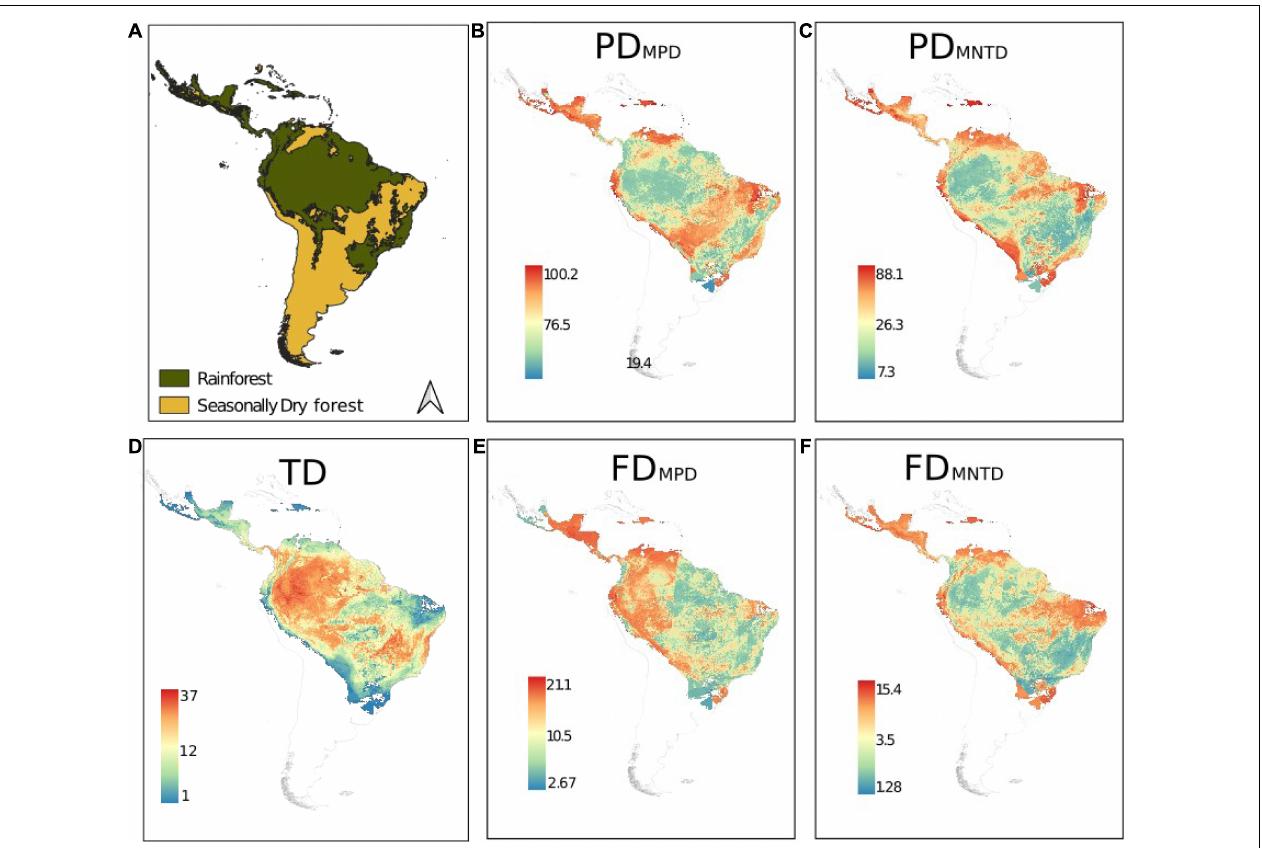
FIGURE 1 | Geographical distribution of the taxonomic (TD), phylogenetic (PD), and functional (FD) diversity of cocosoid palm species in the Neotropics. MPD, Mean pairwise distance. MNTD, mean nearest taxon distance. (A) The classification of areas into rainforests and seasonally dry ecosystems. Phylogenetic diversity calculated using MPD (B) , MNTD (C) , and taxonomic diversity (D) . Functional diversity calculated using MPD (E) and (F) .